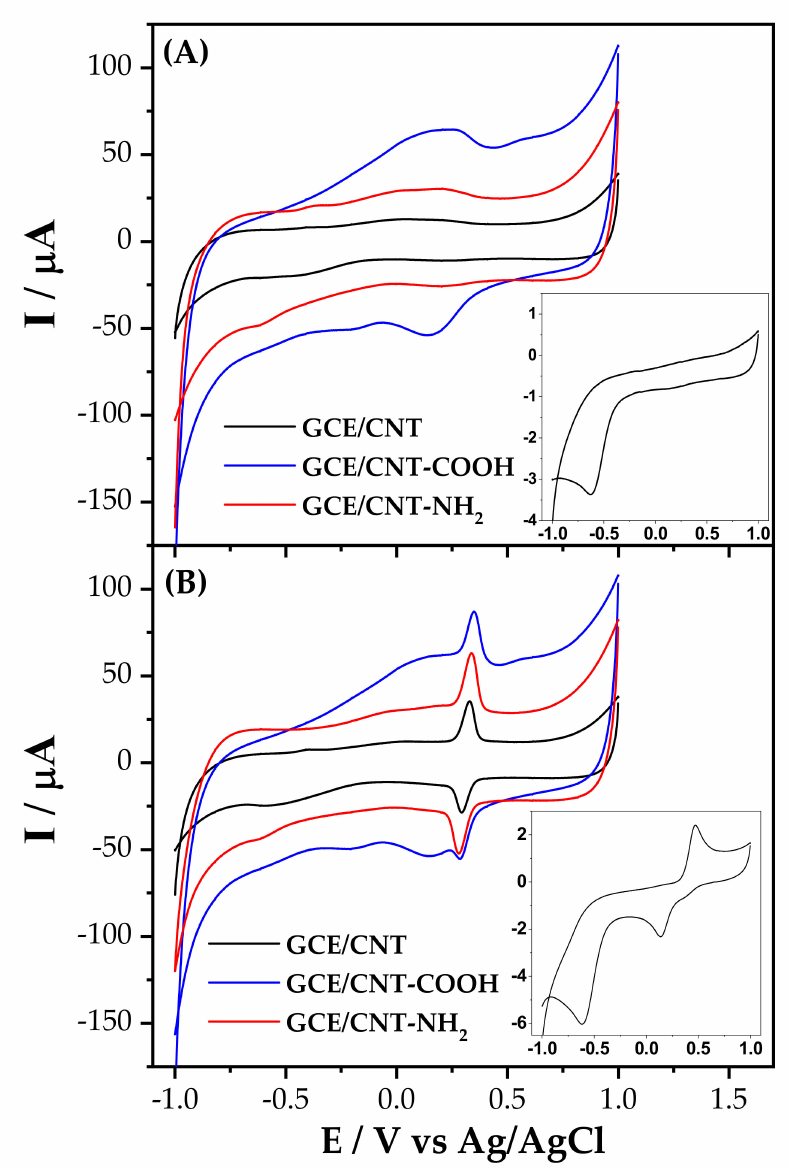
Figure 1. Cyclic voltammograms in the ( A ) absence and ( B ) presence of 0.1 mM of HQ using different electrodes (Inset: Cyclic Voltammogram of GCE-AuNP modified electrode). Experimental conditions: electrolyte buffer Britton–Robinson 0.1 M, pH 2.0, scan rate 50 mV s − 1 , accumulation time 60